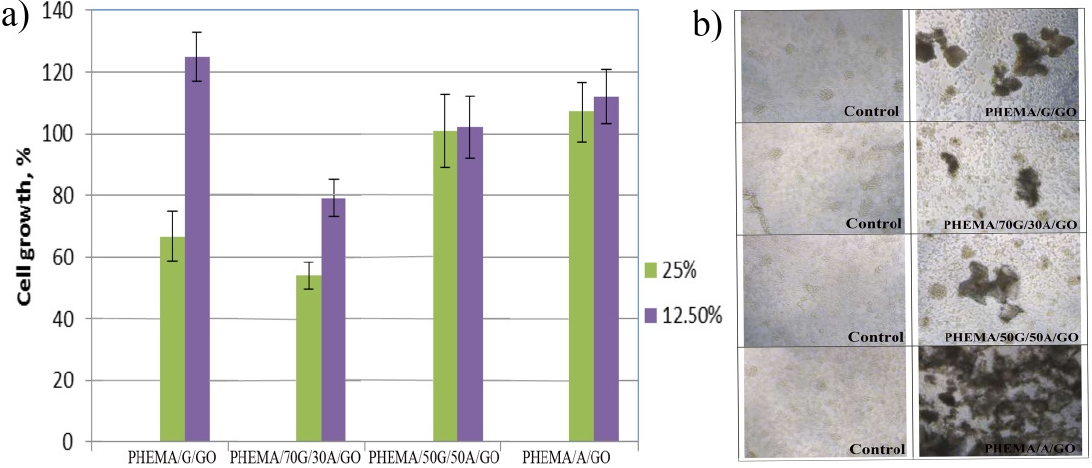
Figure 4. Effect of ( a ) 12.5, and 25% PHEMA/G/GO, PHEMA/70G/30A/GO, PHEMA/50G/50A/GO and PHEMA/A/GO extracts on MRC5 cell viability (Bonferroni test, p = 0.05); ( b ) hybrids supplied directly to MRC5 cells.